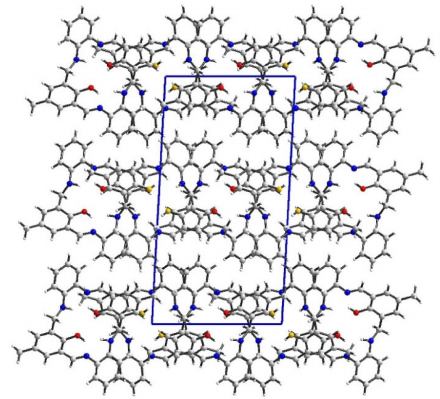
Figure 2. Packing of L1 along b axis. O14 atoms are marked in red and O34 in orange to indicate motifs observed in the crystal